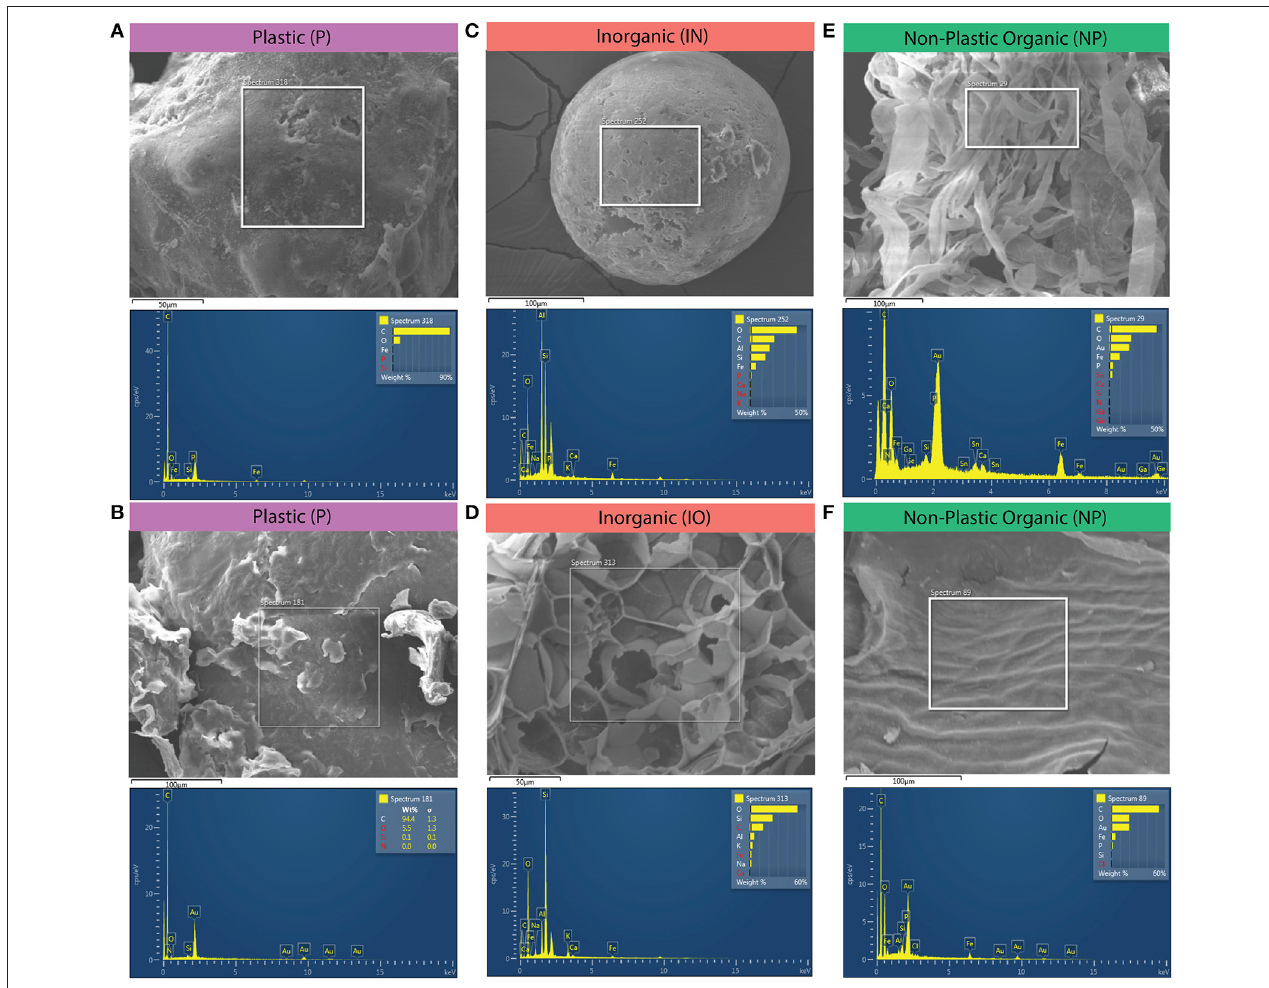
FIGURE 7 | Examples of SEM-EDS spectra and microscopic images representative of the three compositional classes: plastic (P), inorganic (IO), and non-plastic organic (O). (A) plastic fragment. (B) Flaking, jagged, “crumbly” bead from a personal care product that served as a positive control. (C) Coal fly ash from a Lake Erie sample. (D) Piece of silica foam from Lake Erie sample. (E) Stringy, fibrous organic matter particle from Lake Erie sample. (F) Non-plastic organic matter control depicting diagnostic shallow surface veining; likely a leaf or other vegetation.